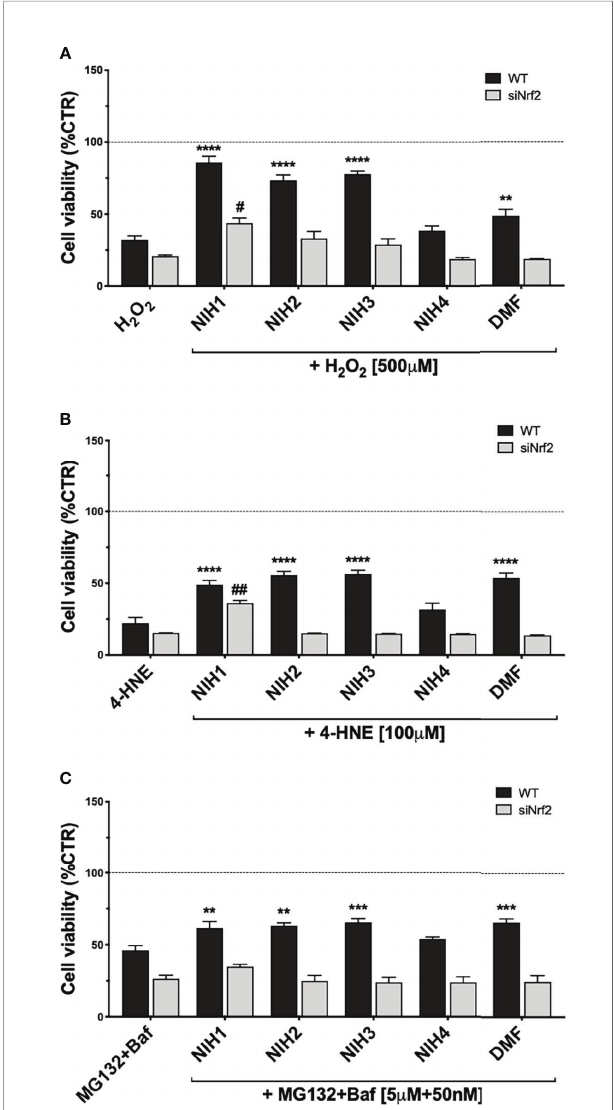
FIGURE 6 | Study of NIH-mediated protection in WT and siNrf2 ARPE-19 cells under different stress. Cell viability was assessed by a fl uorometric assay (PrestoBlue ® ) in WT and siNrf2 ARPE-19 cells pre-treated for 24 h with either solvent (DMSO, CTR), NIH1, NIH2, NIH3, NIH4 [5 m M], or DMF [10 m M, for 24 h] (A) , 4-HNE [100 m M], and then exposed to either H 2 O 2 [500 m M, for 24 h] (B) , or MG132 + Ba fi lomycin [5 m M + 50 nM, for 48 h] (C) . Results are expressed as mean of percentages ± SEM in comparison with control (dot line, 100%). Dunnett ’ s multiple comparisons test; *p <0.05, **p < 0.01, ***p < 0.001, and ****p < 0.0001 versus WT stress; #p < 0.05 and ## p < 0.01 versus siNrf2 stress; n = 5 –